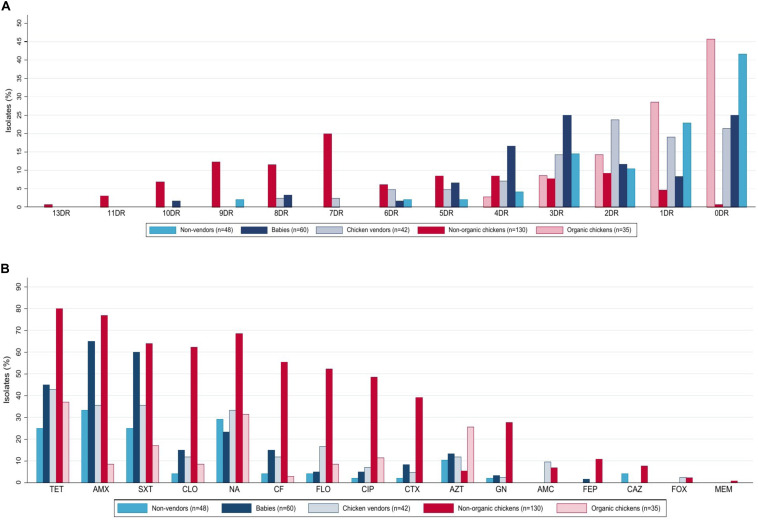
Phenotypic antibiotic resistance of 315 E. coli isolates from humans and chickens in Lima, Peru. (A) Isolates were grouped by number of antibiotics to which they were resistant based on disk-diffusion assays. (B) Based on resistance to 16 antibiotics. (A) Percentage of resistances to different drugs, DR, drug resistance. (B) Resistance patterns to different antibiotics, TET, tetracycline; AMX, amoxicillin; SXT, trimethoprim/sulfamethoxazole; NA, nalidixic acid; CLO, chloramphenicol; CF, cefalotin; FLO, florfenicol; CIP, ciprofloxacin; CTX, cefotaxime; AZT, azithromycin; GN, gentamicin; AMC, Amoxicillin with Clavulanic Acid; FEP, cefepime; CAZ, ceftazidime; FOX, cefoxitin; MEM, meropenem.